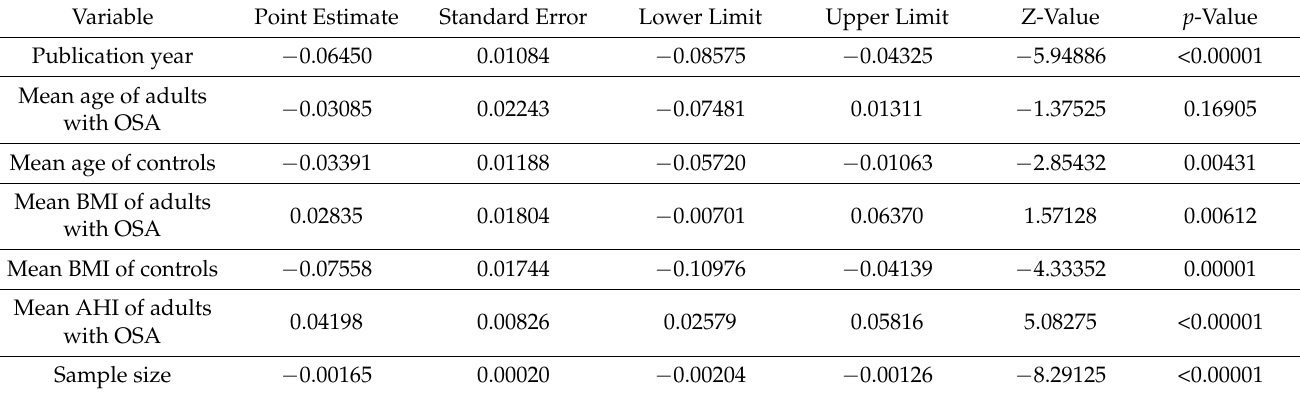
Table 3. Meta-regression analysis in adults with obstructive sleep apnea compared to